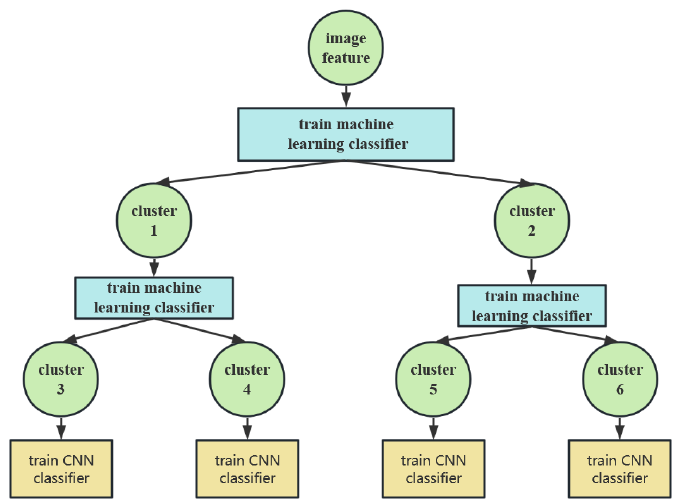
Figure 8. The diagram of the training phase of the tree-structured